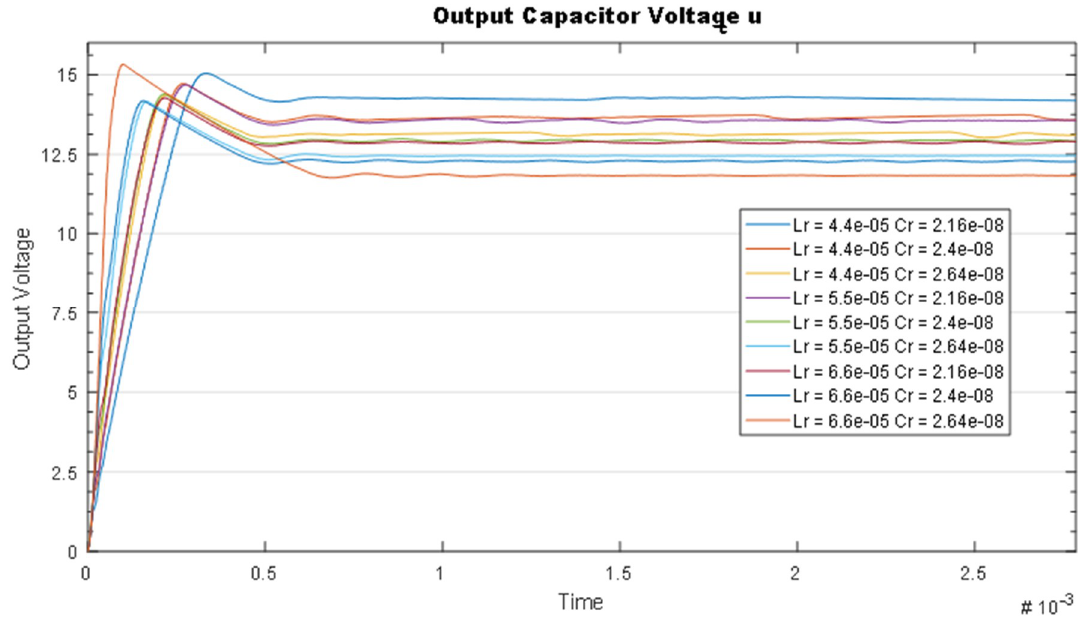
Figure 8. Tolerance analysis of the transient response of the output voltage.